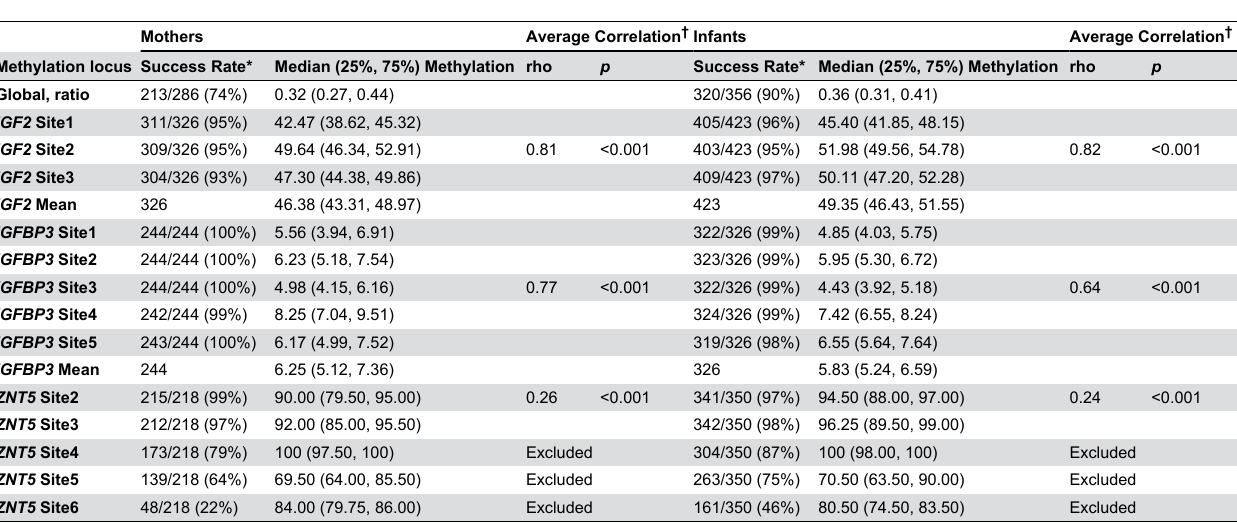
Table 1. Global and loci specific methylation levels and correlation.